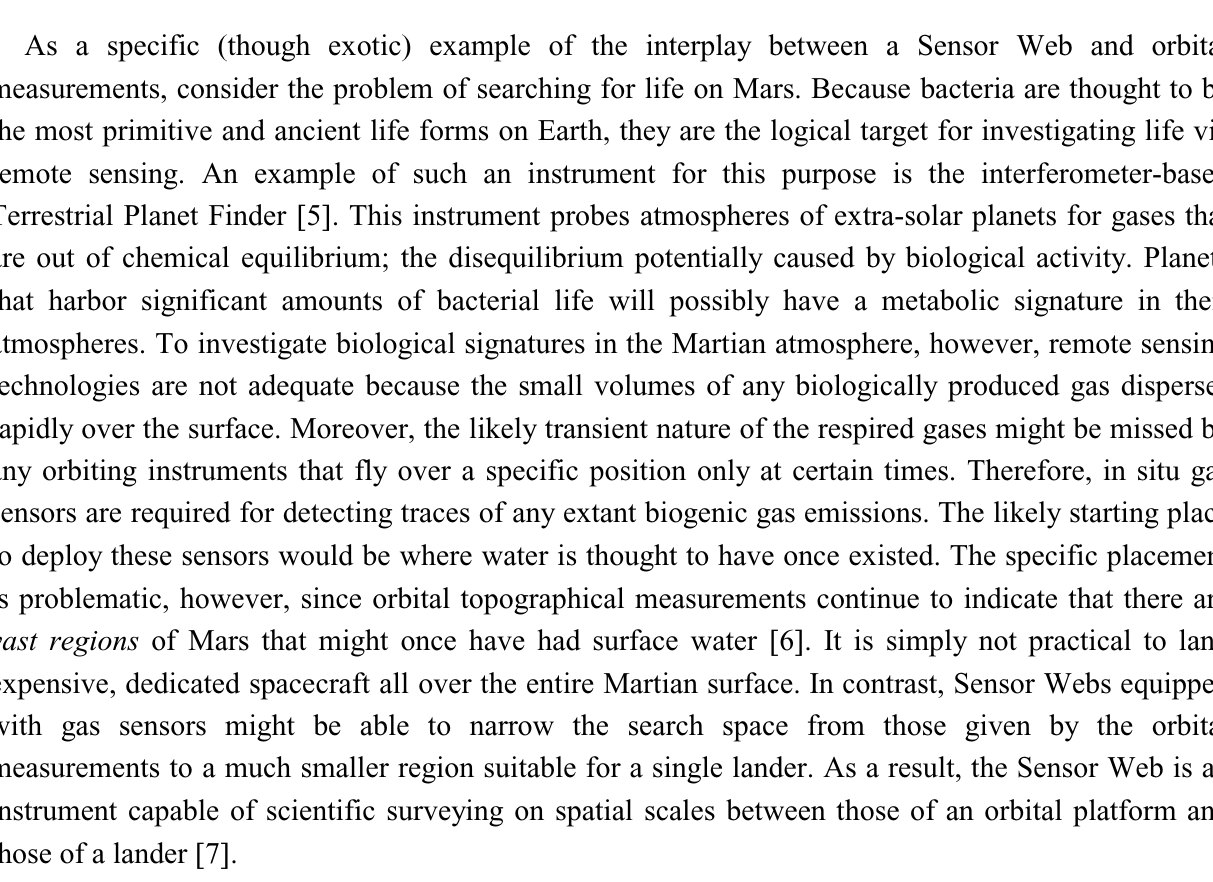
Figure 5. Regions where different measurement techniques